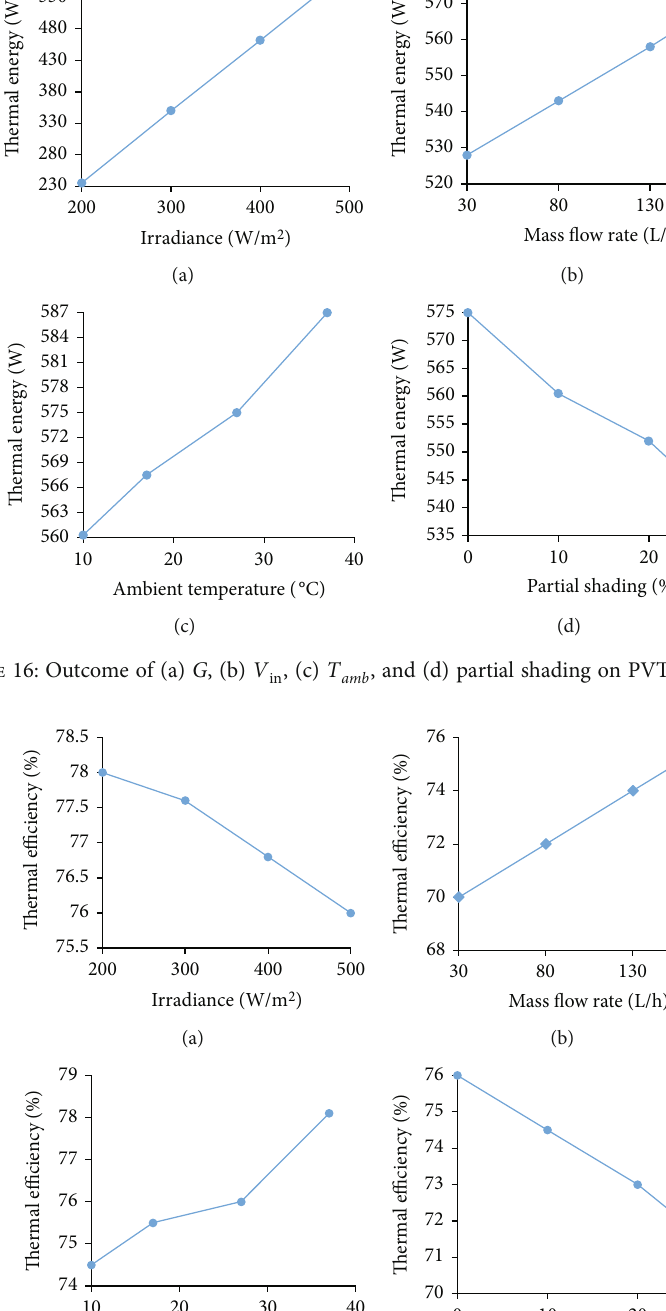
, (c) T , and (d) partial shading on PVT thermal e ffi in amb